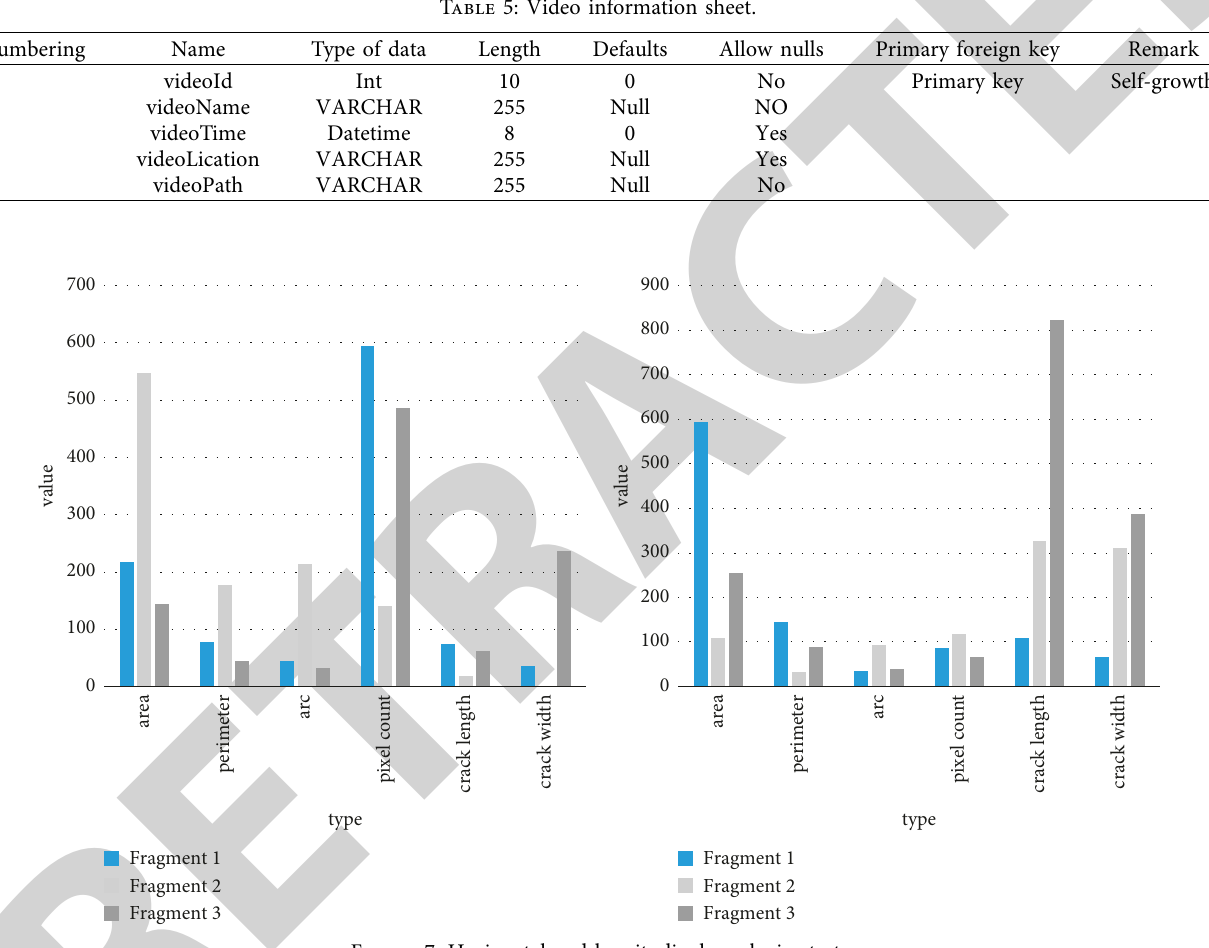
Table 5: Video information sheet.